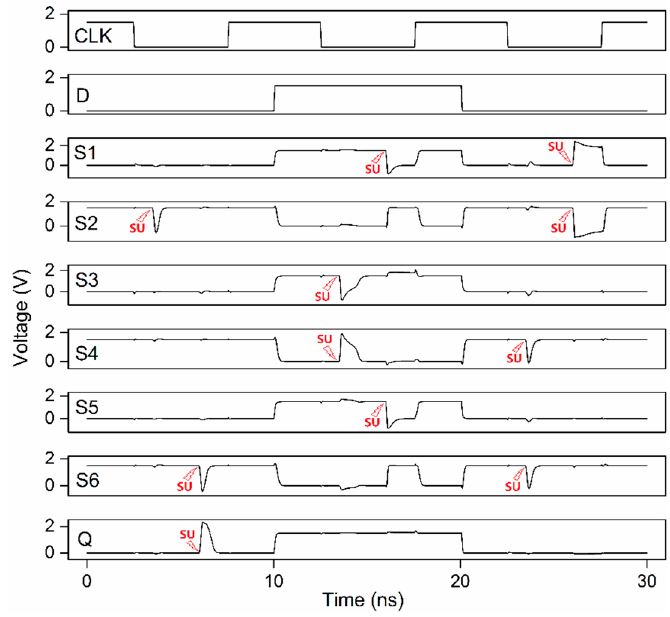
Figure 4. Simulation waveforms for HLDUT latch.